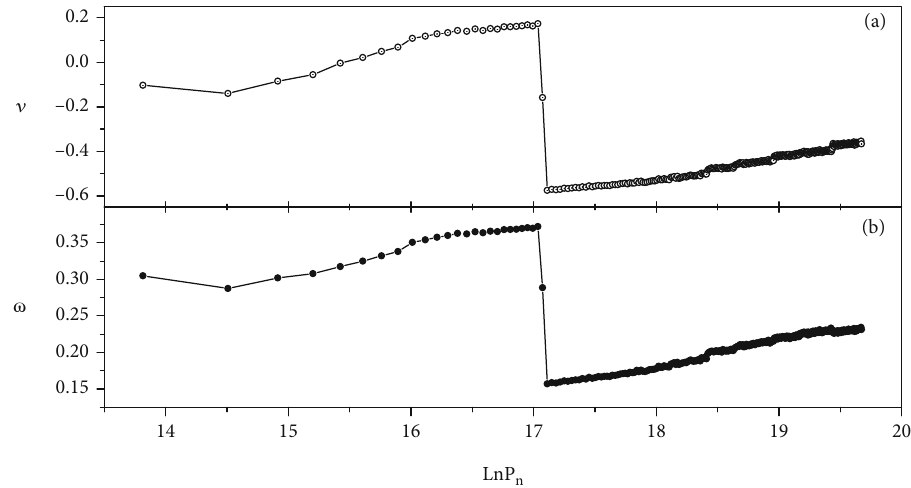
Figure 2: (a) The relation between the natural logarithm of the prime numbers and the inverse χ 2 parameter ν from one million up to 350 million primes calculated for every million separately. (b) The relation between the natural logarithm of the prime numbers and Brody parameter ω from one million up to 350 million primes calculated for every million